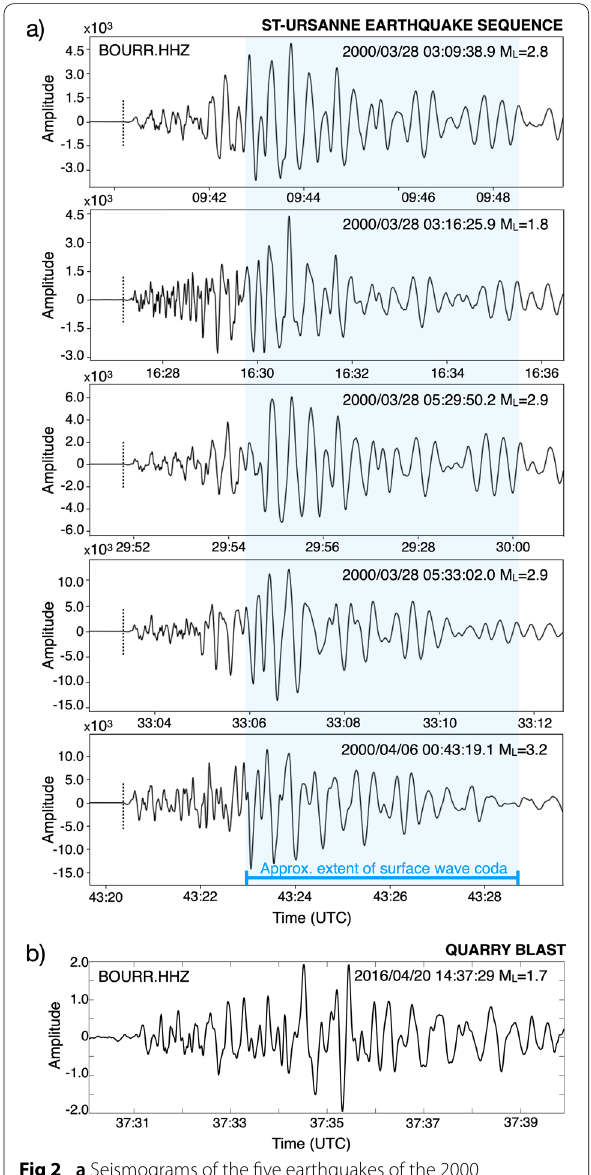
Fig 2 a Seismograms of the five earthquakes of the 2000 sequence recorded at station BOURR (epicentral distance ~ 5 km). b Seismogram of an identified quarry blast from the SED Bulletin located ~ 3 km north of the earthquake sequence of the year 2000 observed at the same station (epicentral distance 7.8 km). Although both blasts and earthquakes are characterized by a strong surface wave component, waveform similarities are low (cross-correlation values <